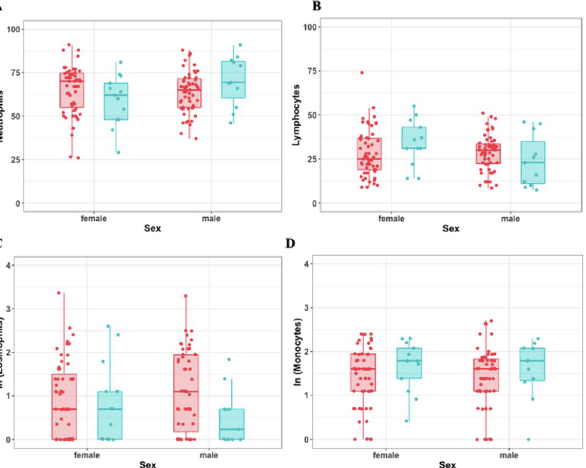
Fig 1. Box and whisker plots displaying the number of neutrophils (A), lymphocytes (B), eosinophils (C) and monocytes (D) observed per 100 cells counted in individuals on which injuries were noted (blue, n = 24) compared to individuals with no evident injuries (red, n = 110). Values of cell populations present in low abundances were log- transformed as ln(x+1) for visualization purposes. https://doi.org/10.1371/journal.pone.0268549.g001 comprised 3.8 to 13% of the general lymphocyte population. These lymphocytes were generally larger and lighter in color than the other lymphocytes typically observed and often had an oval